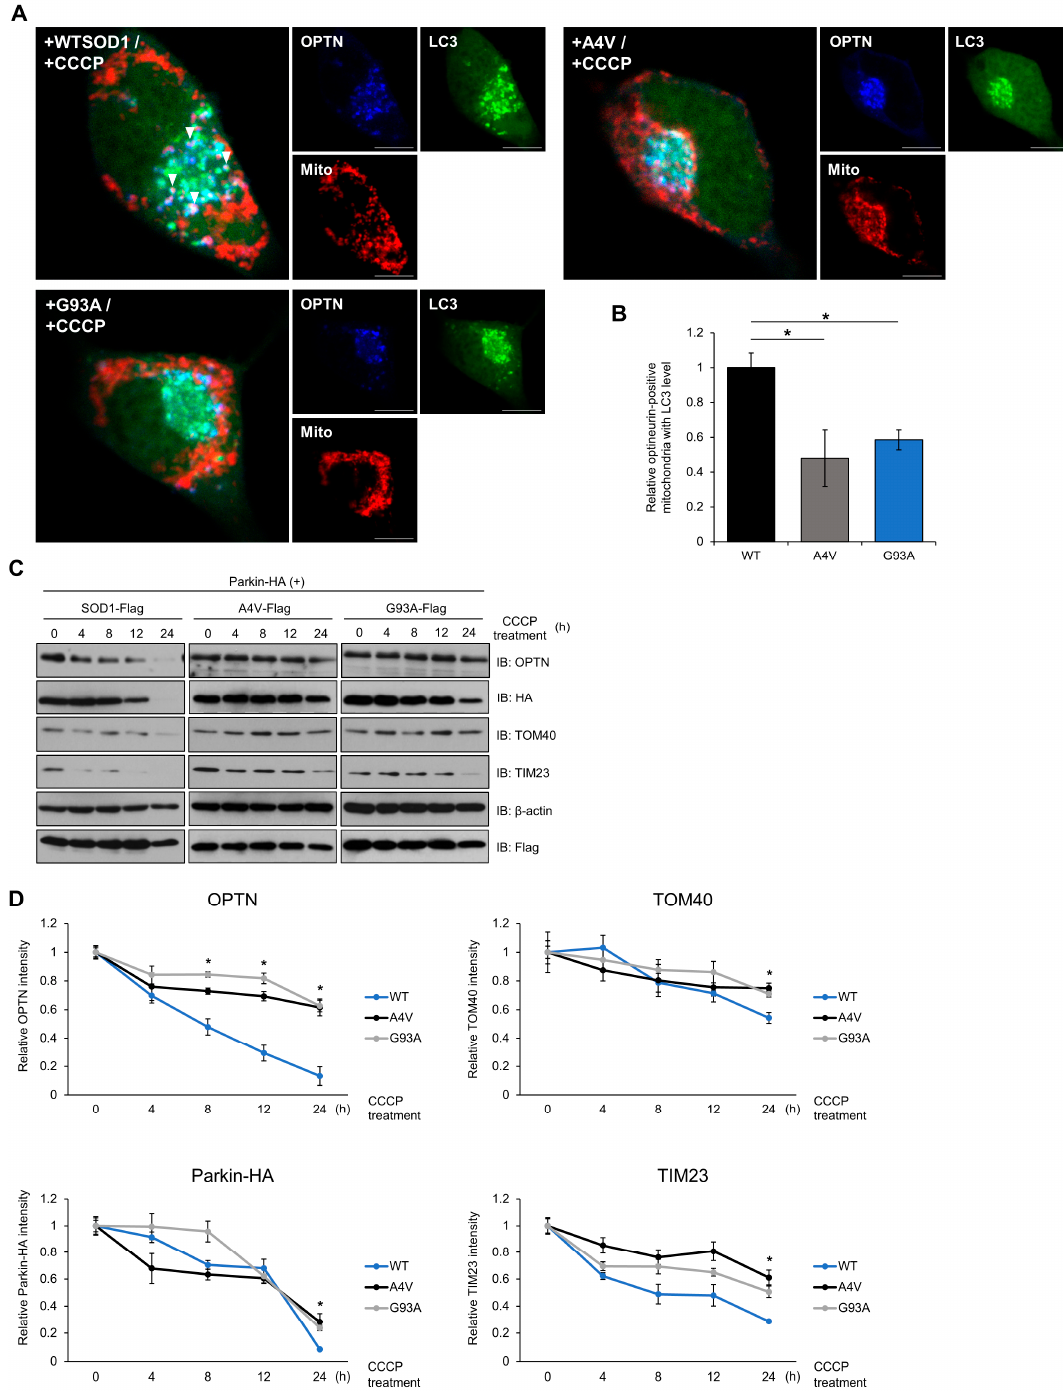
Figure 4. Mutant SOD1 aggregates inhibit mitophagosome formation and mitophagy flux. ( A , B ) N2a cells were transiently transfected with LC3-GFP, Myc-Parkin-HA, DsRed-mito, and FLAG-tagged SOD1 (WT, A4V or G93A) for 48 h. Cells were immunostained with anti-OPTN antibodies after CCCP treatment (20 μ M, 3 h). Arrows indicate mitochondria surrounded by mitophagosomes. The number of OPTN-positive mitochondria with LC3 was measured by the counting method. n = 21–30 cells per group. Scale bar = 10 μ M. ( C , D ) Mitochondrial protein degradation detected by Western blotting. Treatment with CCCP (20 μ M) to induce mitophagy was performed with N2a cells expressing Myc-Parkin-HA and FLAG-SOD1, FLAG-A4V, or FLAG-G93A for various time periods. The lysates were immunoblotted with antibodies against TOM40, TIM23, OPTN, FLAG, HA, and β -actin. The results were normalized to β -actin. * p < 0.05.